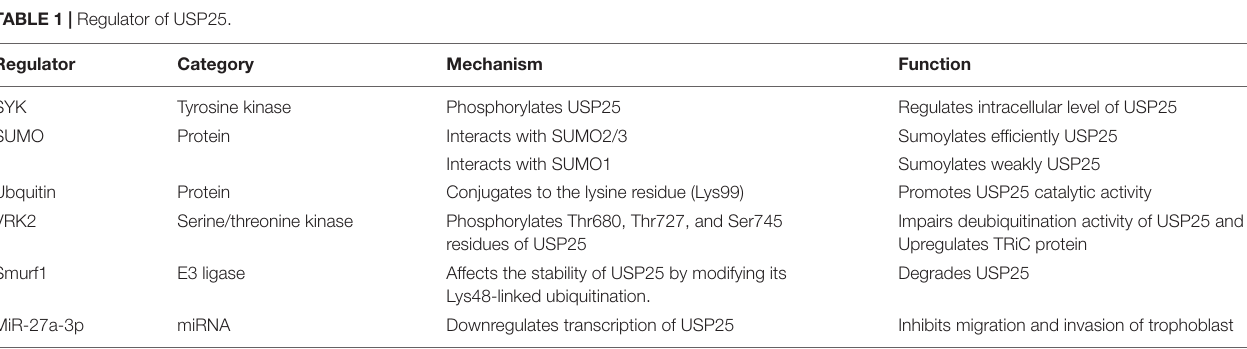
TABLE 1 | Regulator of